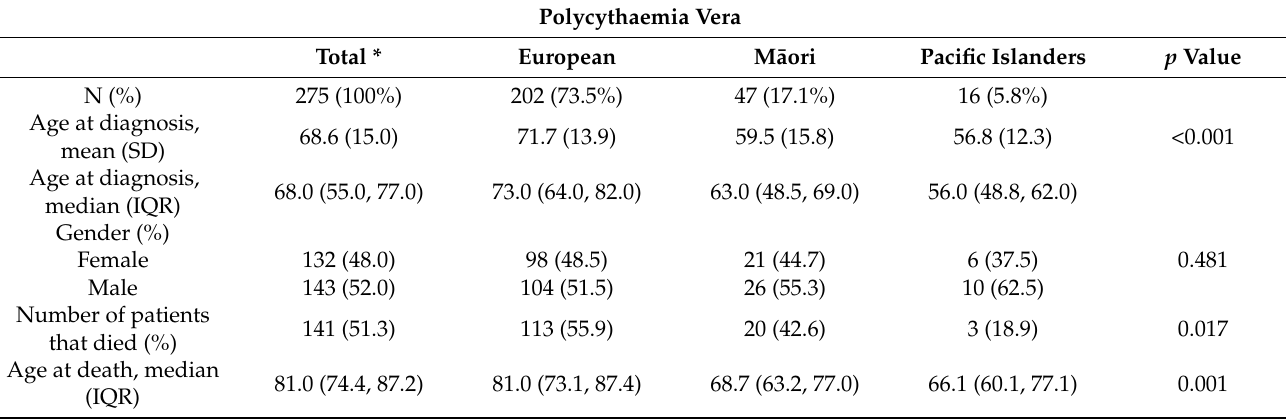
Table 1. Characteristics of three classical Ph-negative myeloproliferative neoplasms captured by the New Zealand Cancer Registry, 2010 – 2017 ( n = 787).